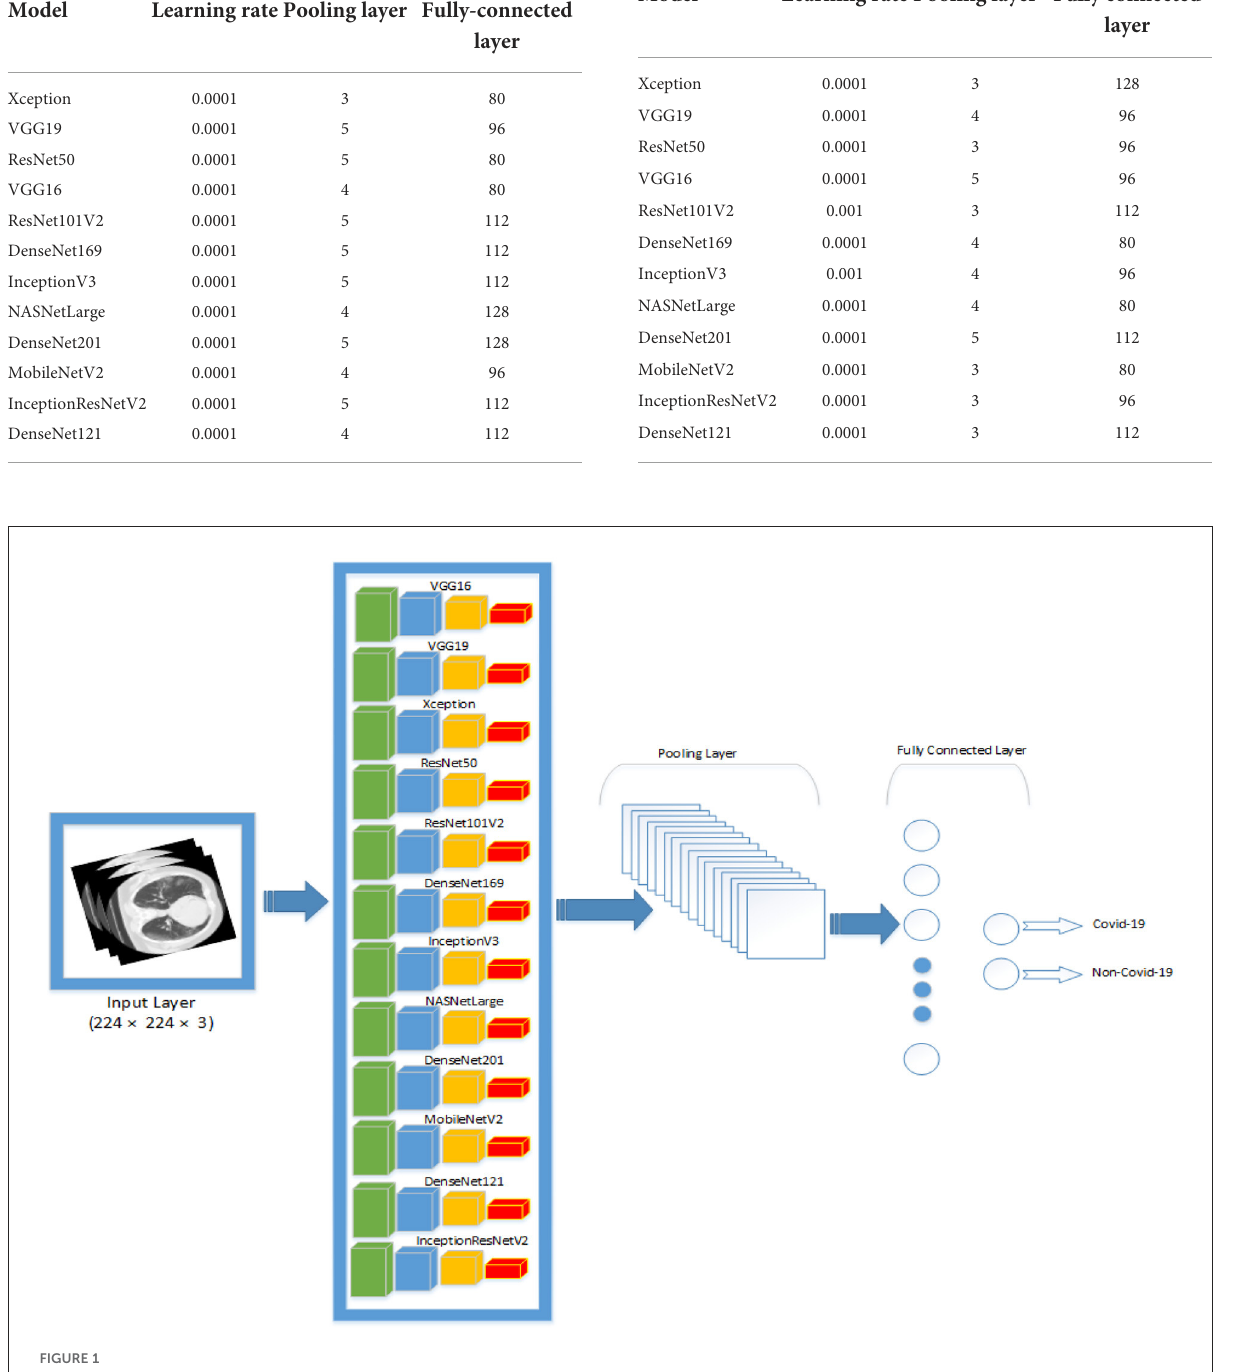
FIGURE1 An overview of the network architecture that was used in this study. All the pre-trained networks are passed through one pooling layer, one fully-connected layer and one output